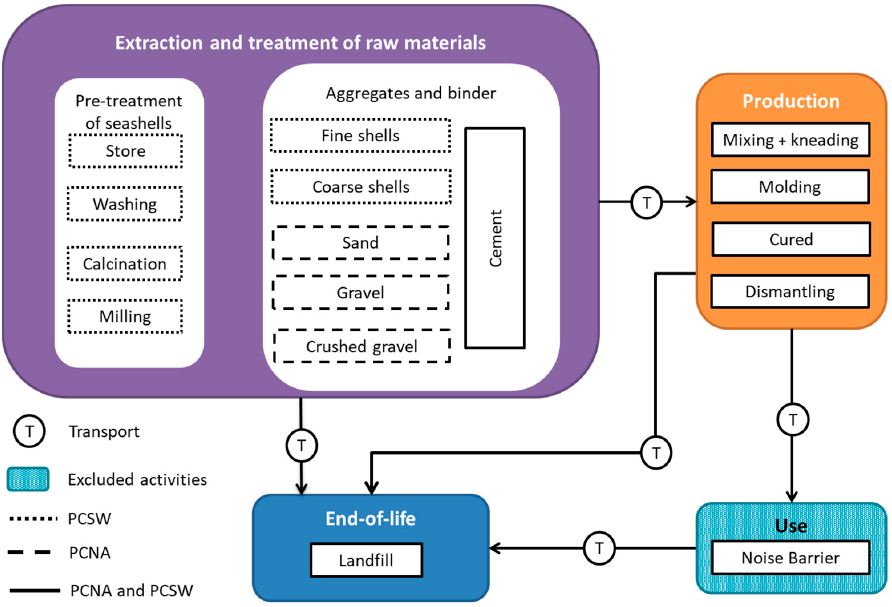
Figure 1. System boundaries for the life cycle of noise barriers using porous concrete with natural aggregates (PCNA) and aggregates from seashell waste (PCSW).